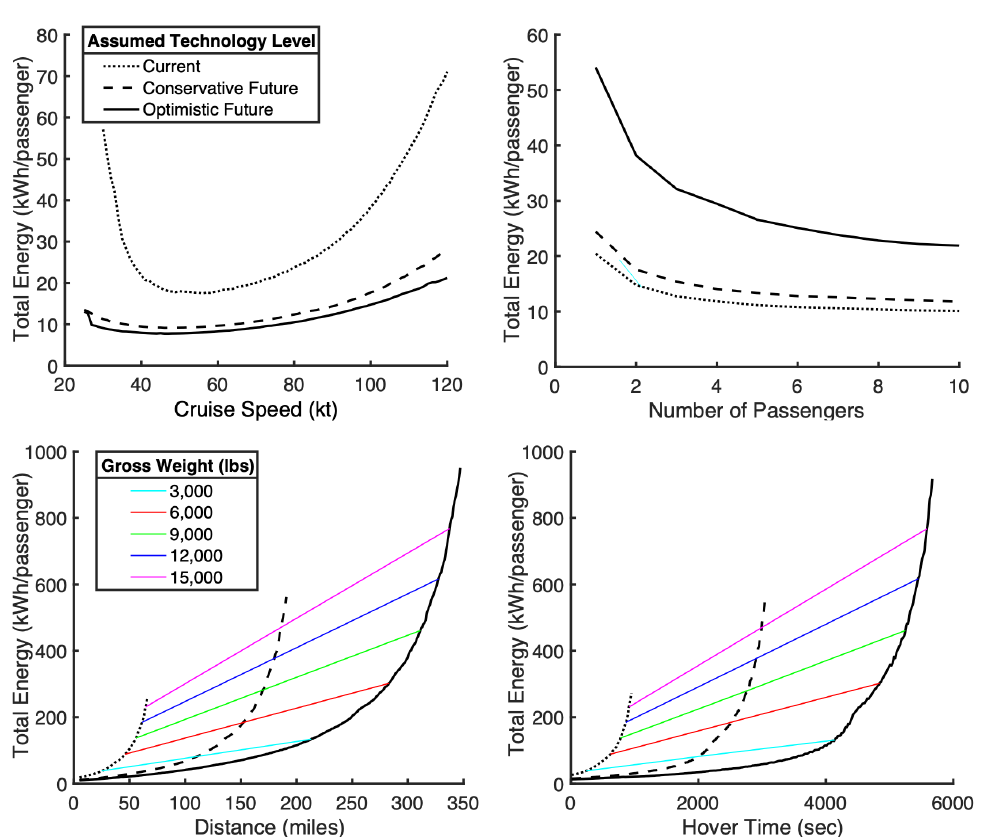
Figure 7. Total energy per passenger for a sweep of mission parameters with varying technology assumptions for a lift-augmented compound